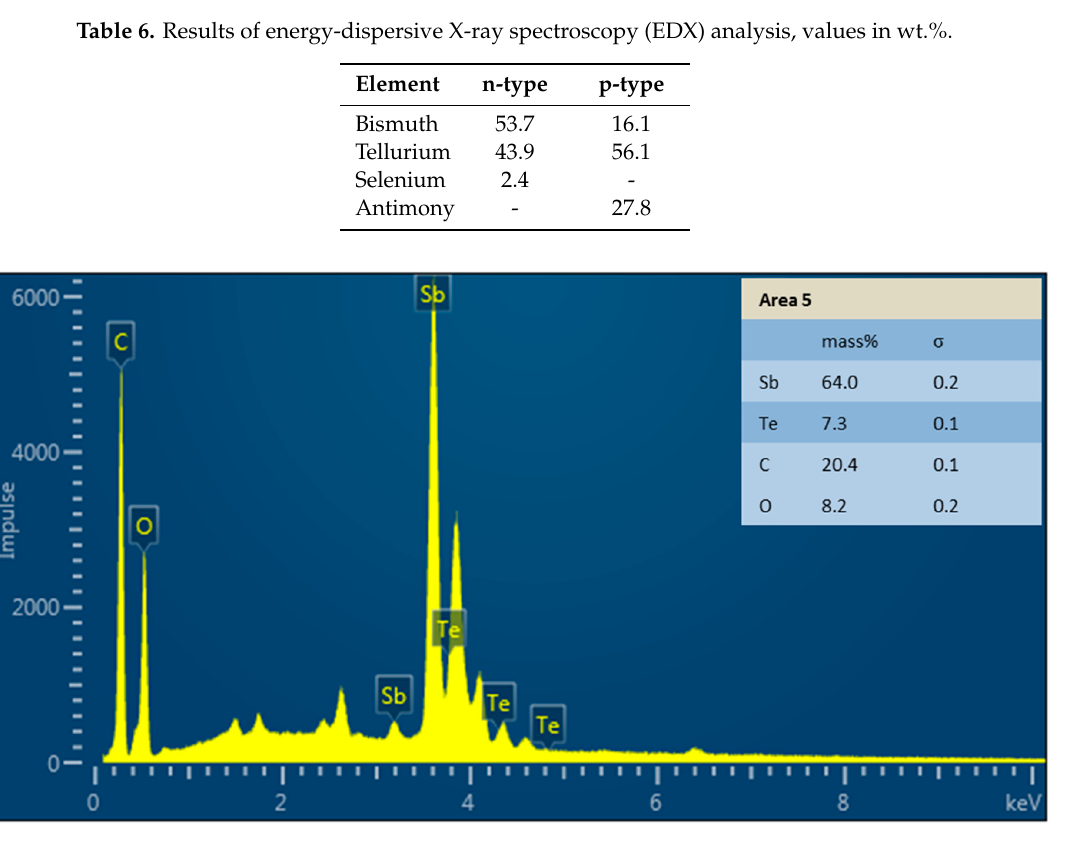
Figure 11. Peaks of the energy-dispersive x-ray spectroscopy (EDX) analysis of Area 5.